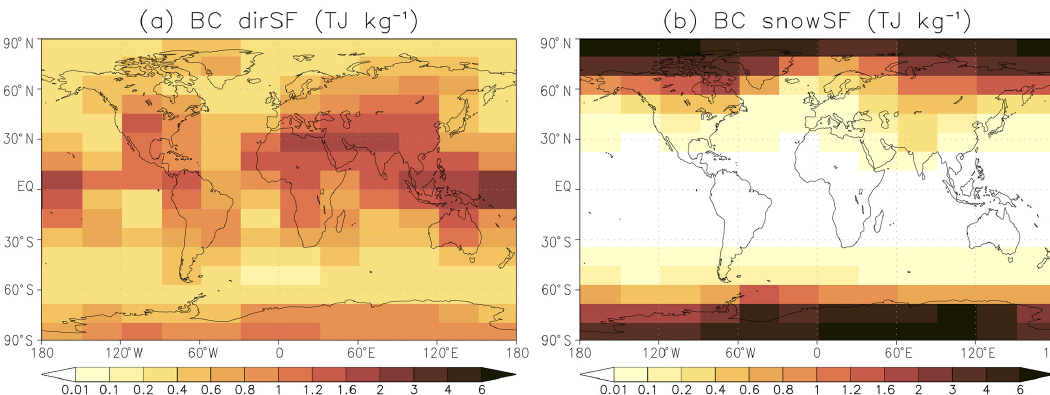
Figure 4. Global mean values of (a) BC direct specific forcing and (b) specific forcing due to BC in snow (TJkg − 1 ) for the experiments in which uniform BC emissions over the year were assumed separately for emissions in each of the 192 lat–long boxes.